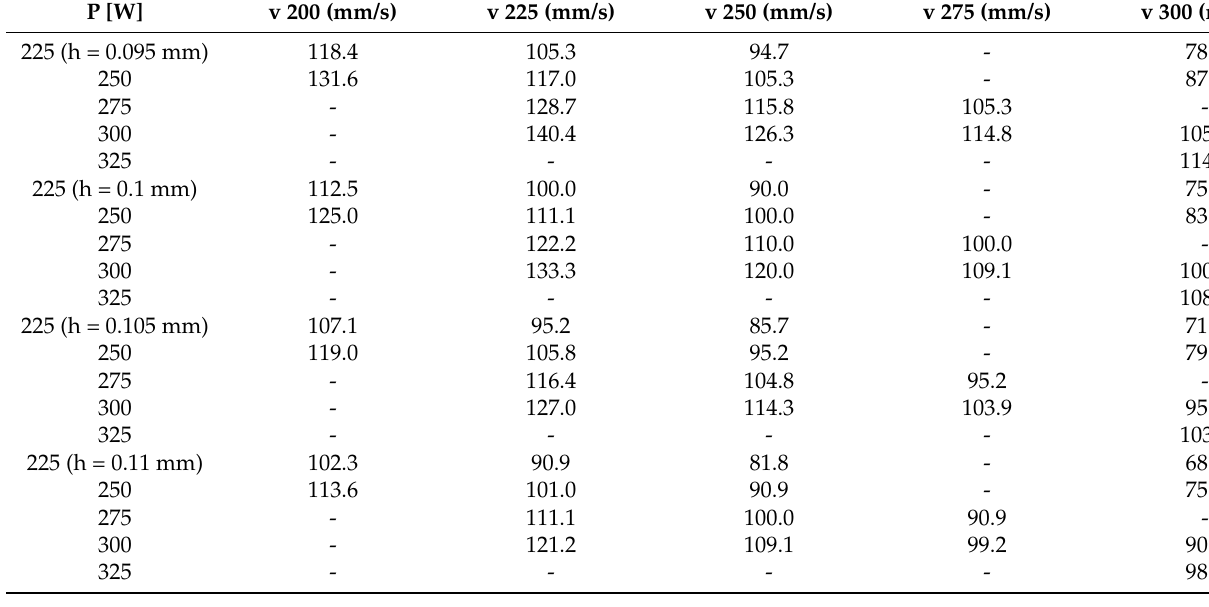
Table 6. Proposed parameters for 3D printing volume samples (volume energy density E 3 (J/mm 3 )).